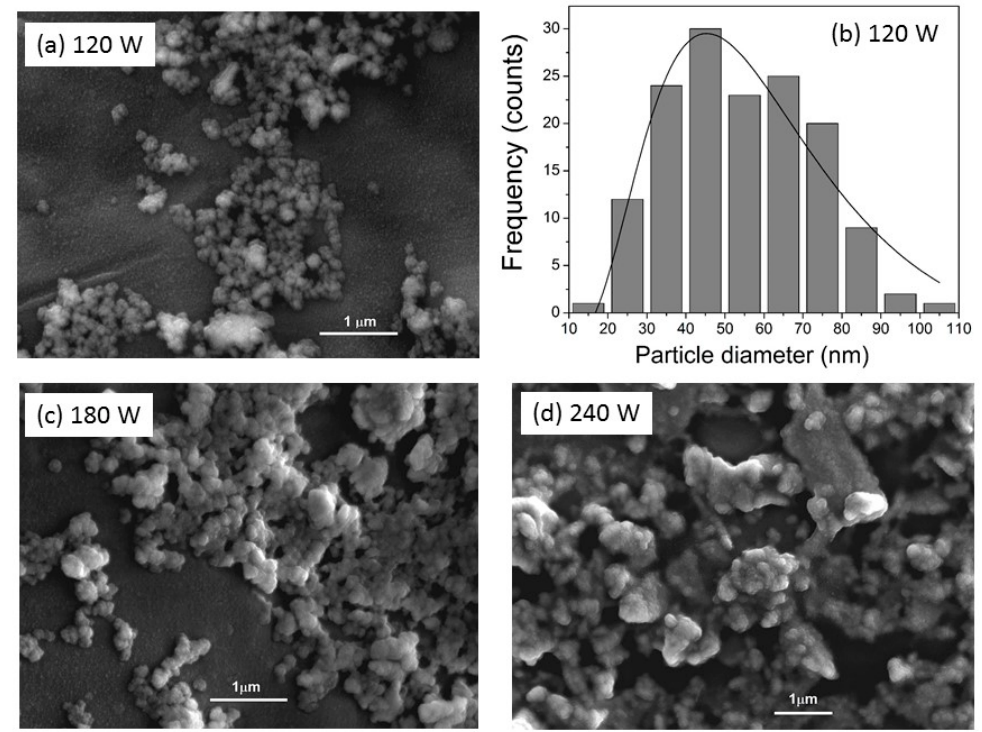
Figure 6. Micrographs of powders “as obtained” synthesized at different SOP values: ( a ) 120 W; ( b ) Histogram of particle size distribution of the powder obtained at 120 W; ( c ) 180 W; and ( d ) 240 W.